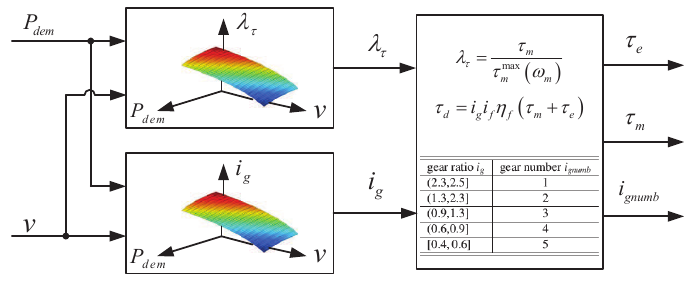
Figure 3. Control schematic diagram in the HEV mode.